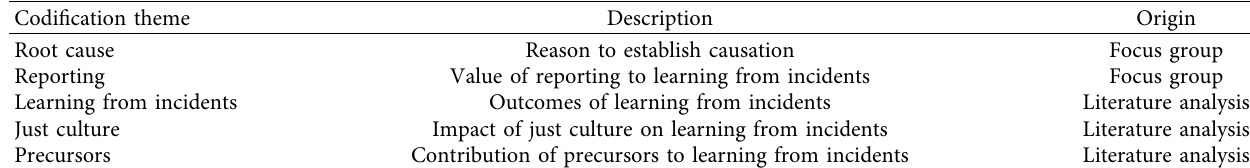
Table 2: Codification themes used in the NVivo analysis of the final set of publications.